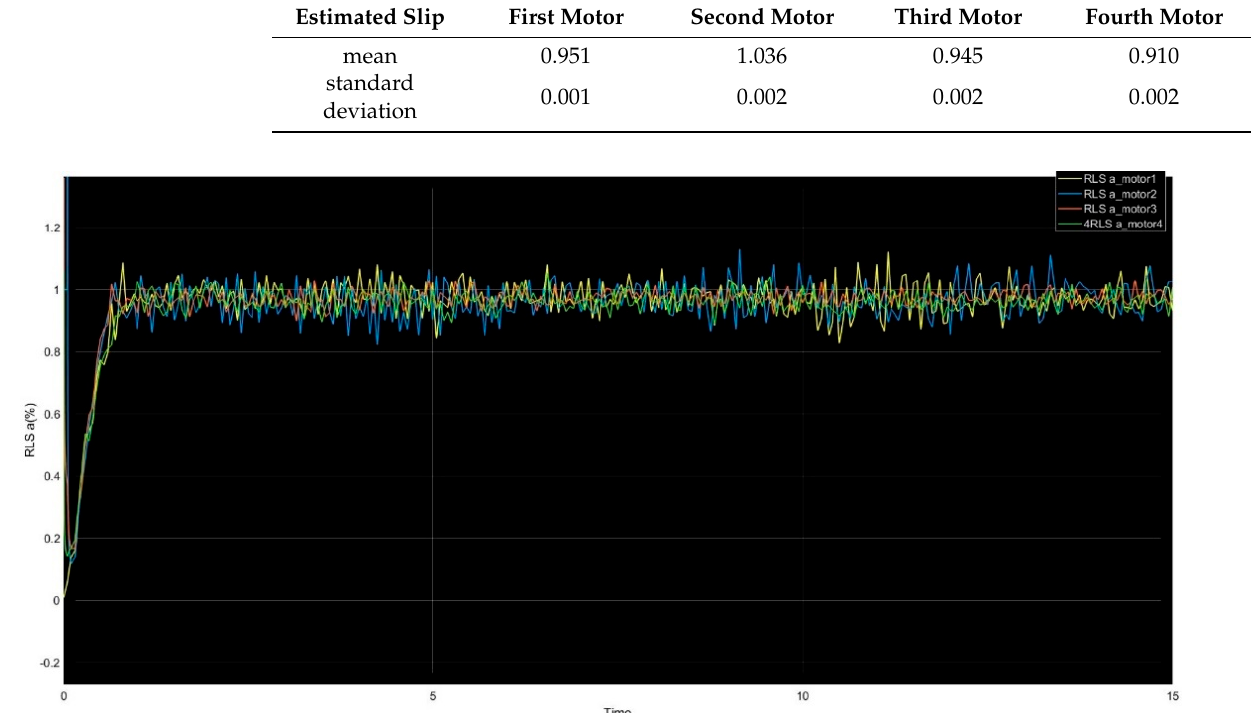
Figure 10. Estimated values by RLS method of four motors. Table 1. The means and standard deviations of the speeds in Figures 6–9 (unit: cm/s).